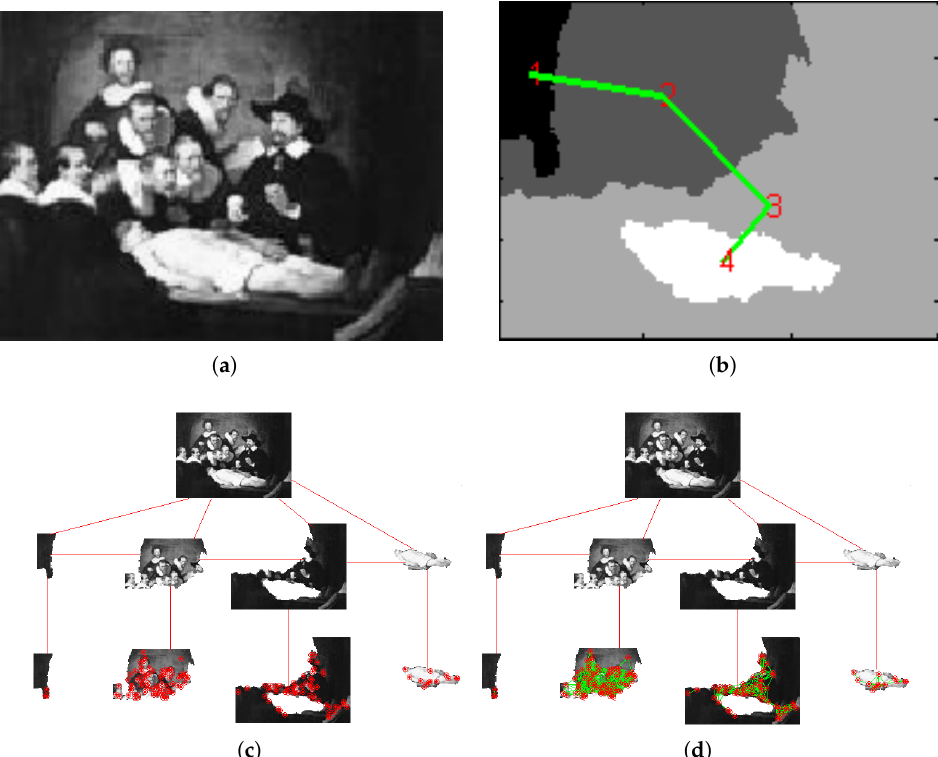
Figure 2. ( a ) Original image; ( b ) RAG composed of four regions; ( c ) region-based leaf node configuration; ( d ) region graph-based leaf node configuration. The red points in ( c , d ) represent SIFT keypoints belonging to regions, while the green lines in ( d ) represent the edges of the graph-based leaf node